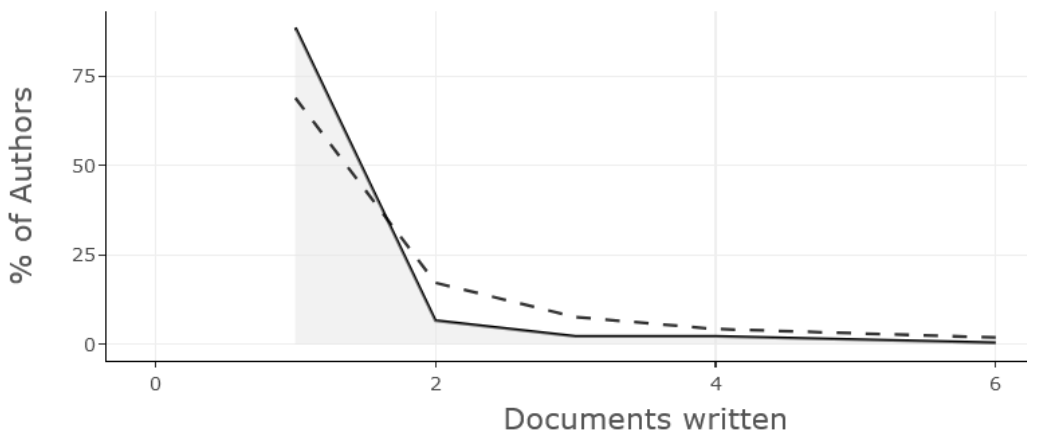
Figure 4. Author productivity (gray) compared with Lotka’s Law (dashed); percentage of authors against number of publications.